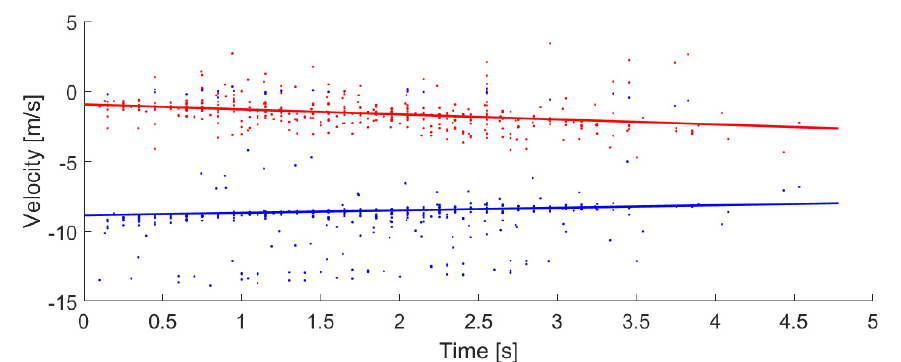
Figure 8. Time–velocity graph of cubes from curvy linear motion: the cube velocities along the X and Y directions are depicted with blue and red dots, respectively; in this example, a constant acceleration (CA) motion model is used, thus the parameters a line are estimated with regression.